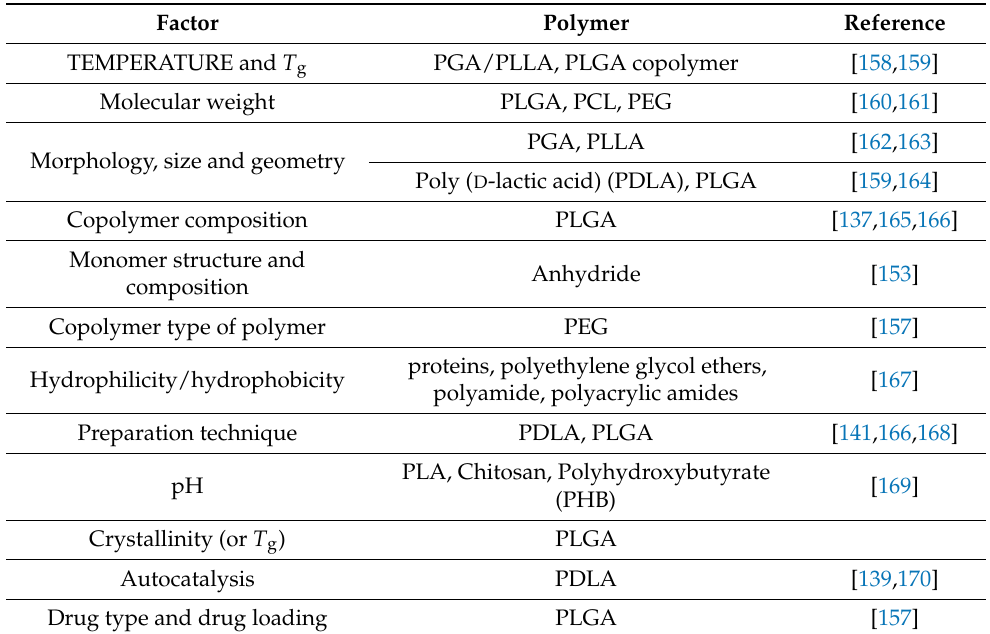
Table 3. Influence of various factors on the polymer